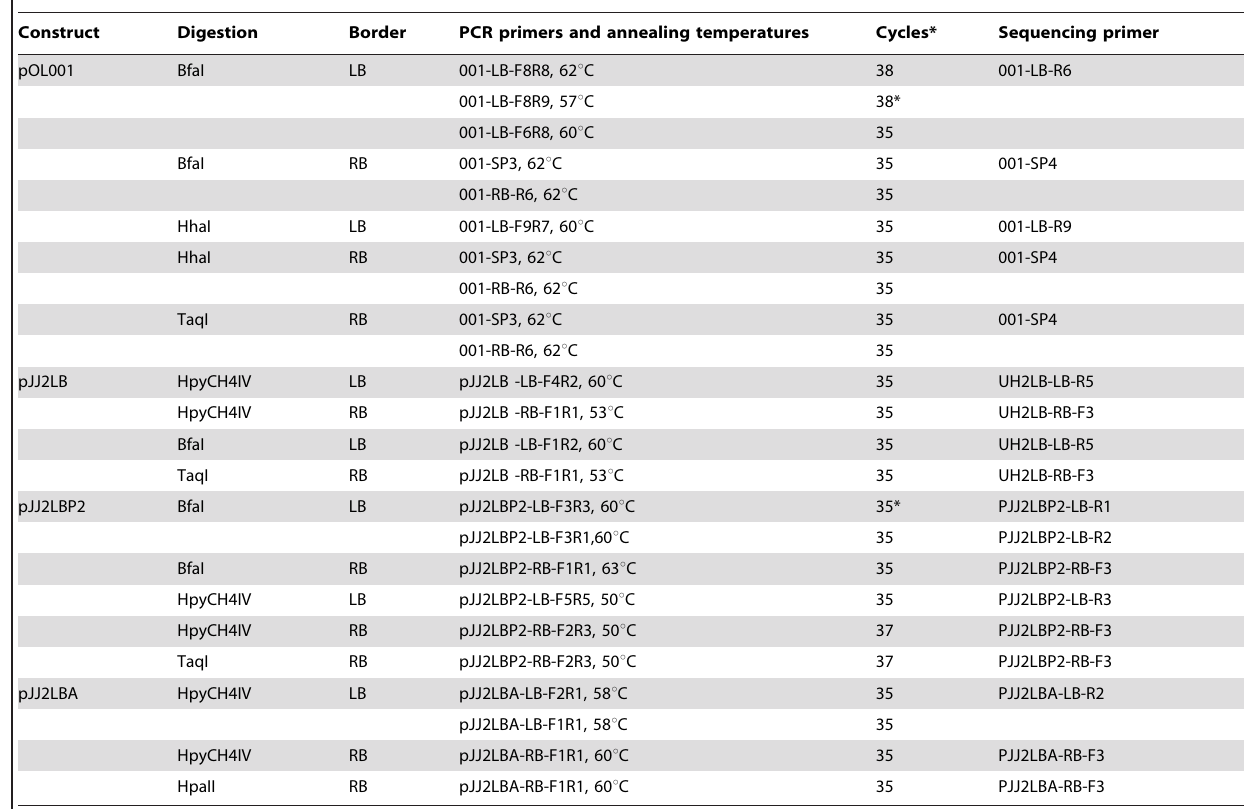
Table 1. Restriction enzymes and primers used for Inverse